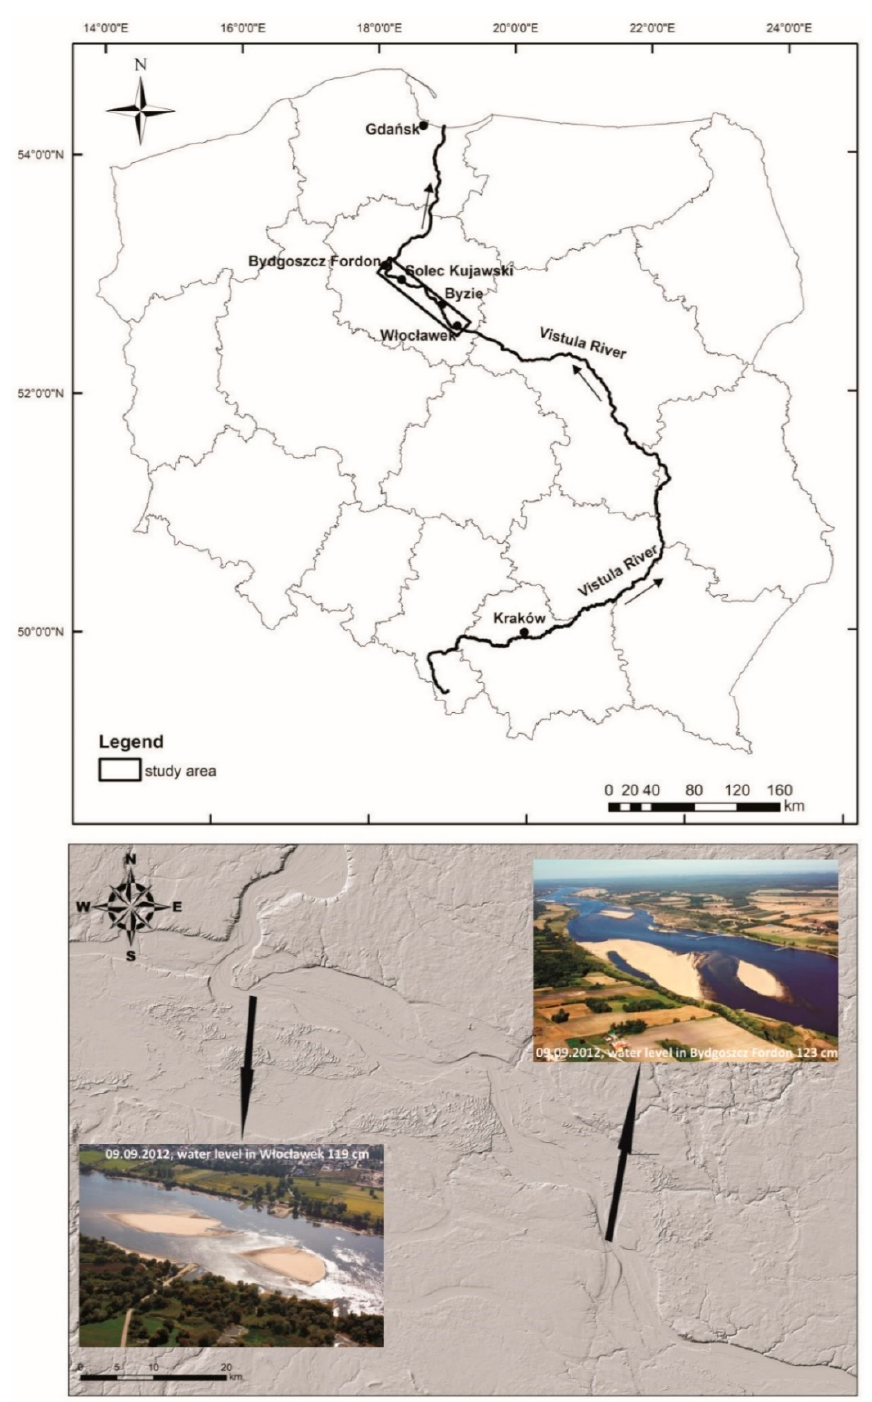
Figure 2. Location of the study area in Europe and in Poland.